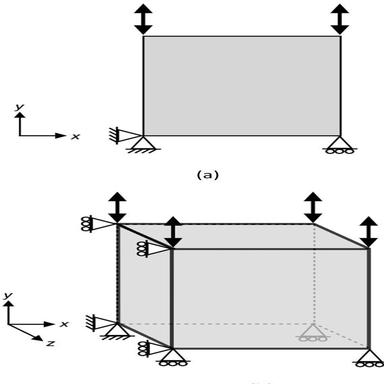
Single-element boundary conditions for (a) shell and (b) solid elements.